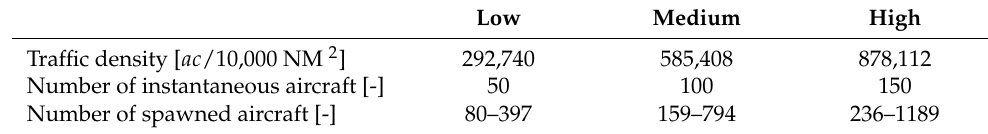
Table 3. Traffic volume used in the experimental simulations. The number of spawned aircraft correspond to 20 min of simulation time; the range results from different flight paths as the necessary time to traverse the environment is dependent on the initial direction(s) and the number of turns. Low Traffic density [ ac /10,000 NM 2 ] Number of instantaneous aircraft [-] Number of spawned aircraft